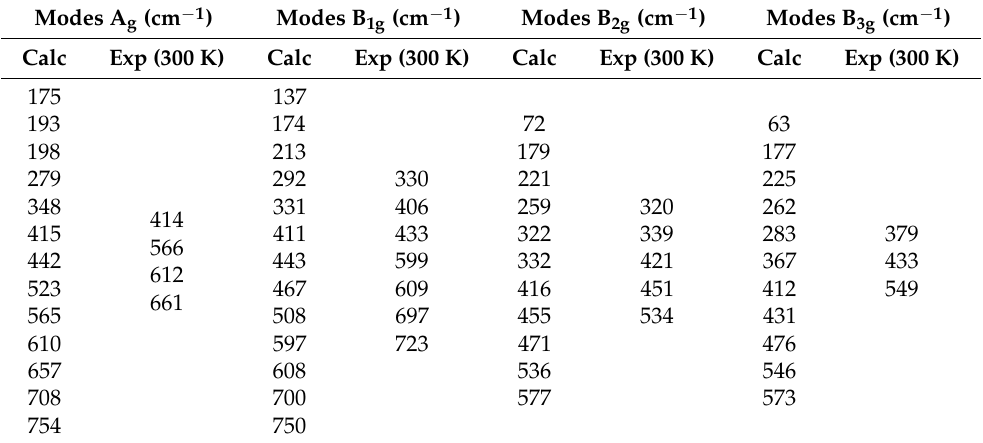
Table 2. Experimental and theoretical frequencies of the Raman phonons of BiMn2O5 [29].